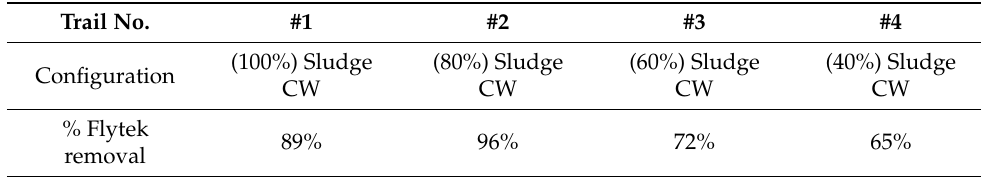
Table 1. Typical data of CW configuration column.